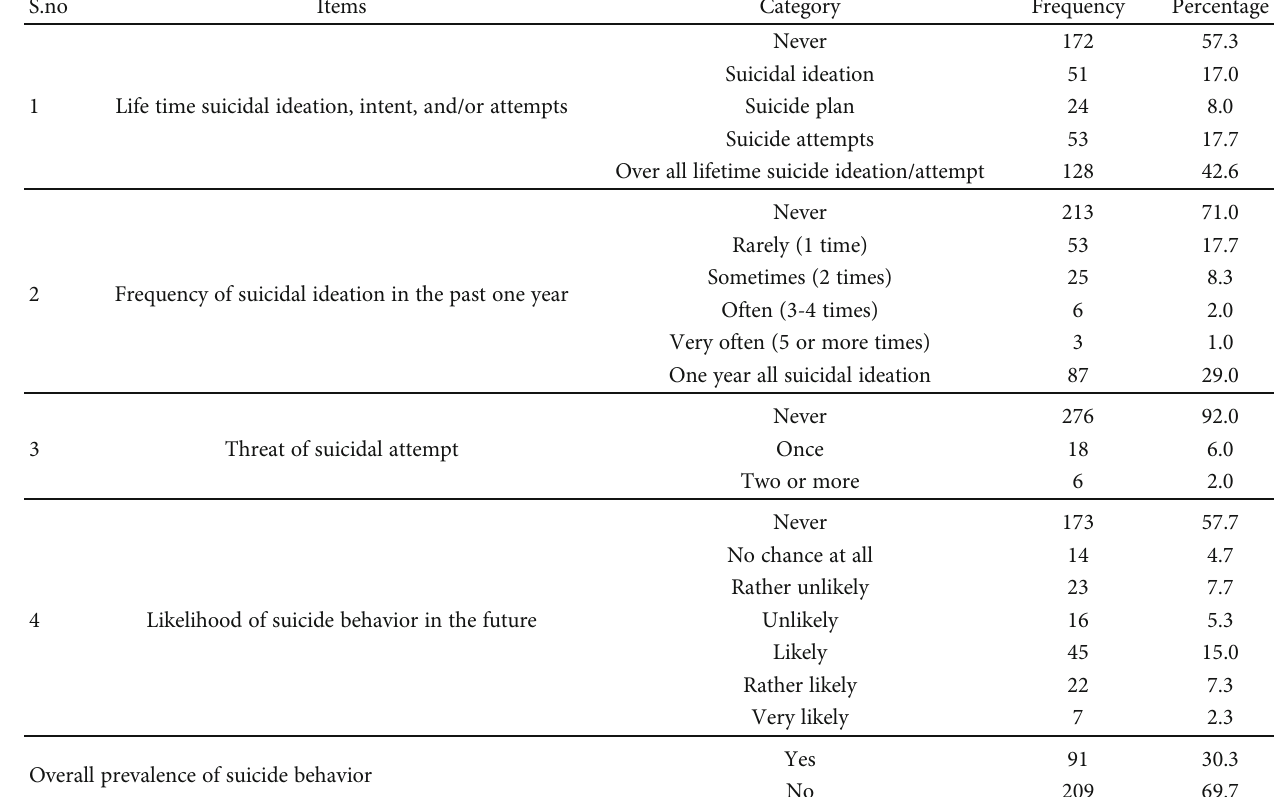
Table 3: Suicide behavior among patients with schizophrenia at AMSH, 2019 ð n = 300 Þ